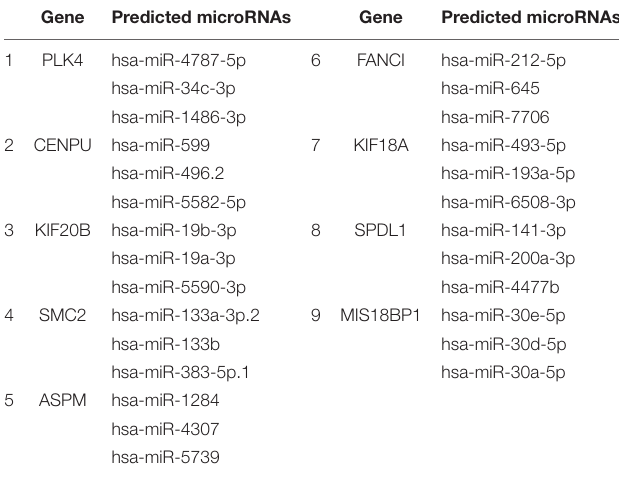
TABLE 3 | The potential microRNAs associated with the hub genes.